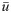
Simultaneous suppresion of both sources of fluctuations.For all panels, shown in the main window is the variance as a function of the strength of regulation and shown in the inset is the mean as a function of the strength of regulation. Low u¯ implies noisier input u and higher extrinsic variability. When the dominant source of variability is input fluctuations, then a strong regulation strategy is preferable. However when the contributions of input fluctuations and chemical reaction stochasticity are comparable, then strategies with smaller gains are preferable. This is especially true for the decoupled implementations. A. Coupled FB implementation B. Coupled IFF implementation C. Decoupled FB implementation D. Decoupled IFF implementation. Values were obtained using 40,000 SSA simulations of models shown in Table B in S1 Text.